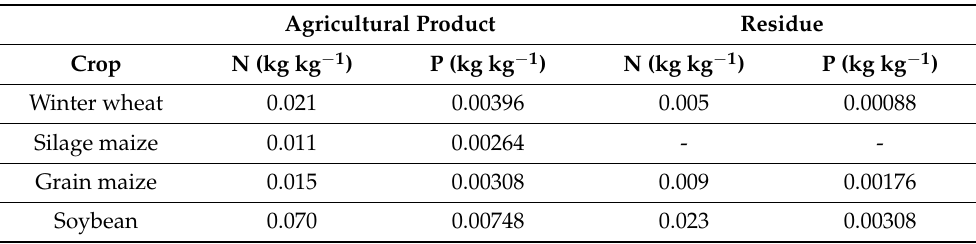
Table A3. Nitrogen (N) and phosphorus (P) harvest indices for the agricultural products and residues of each studied